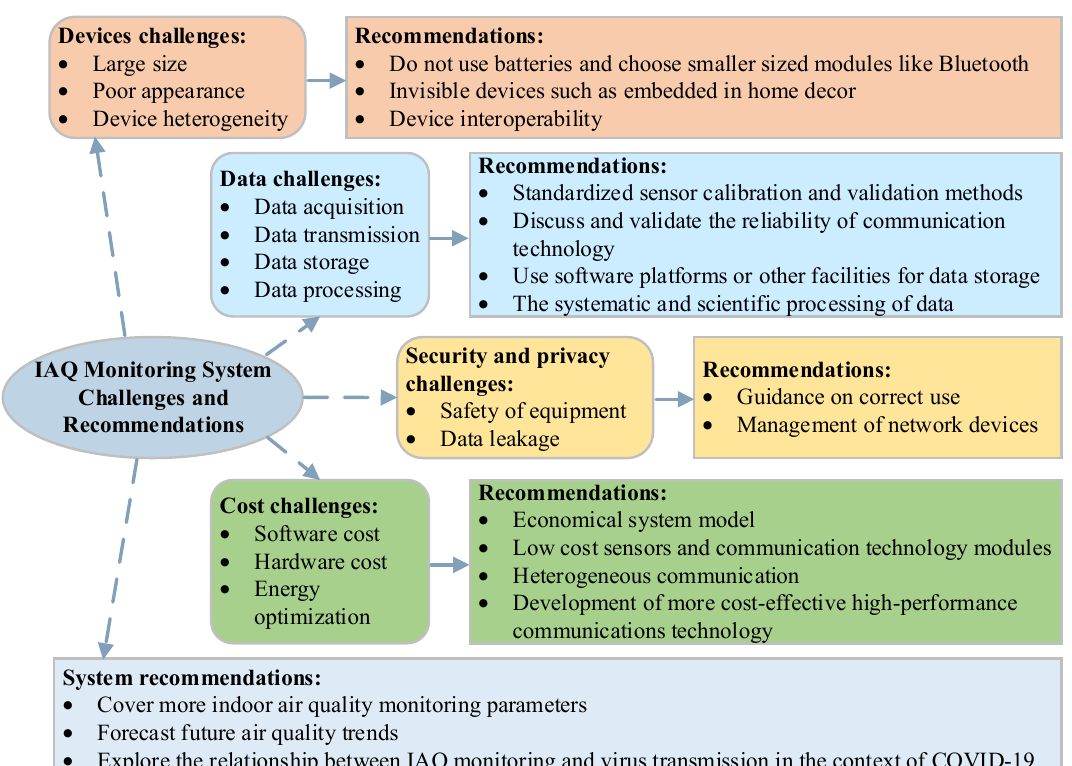
Figure 8. Challenges and recommendations for IAQ monitoring system.